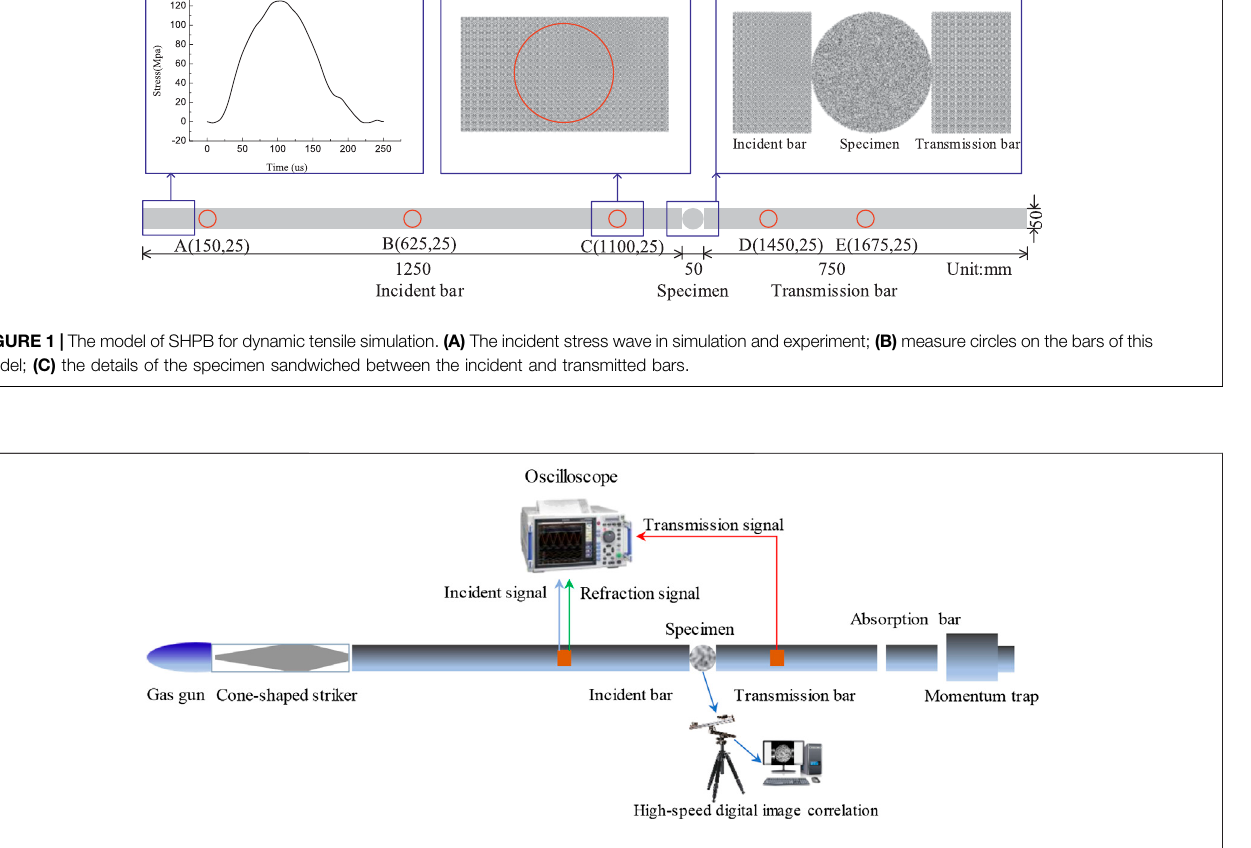
Figure 1 . The stress wave ( Figure 1A ) is loaded on the left end of the incident bar. Five measure circles ( Figure 1B ) are embedded in the incident and transmitted bars. Figure 1C contains the details of the specimen sandwiched between the incident and transmitted bars.